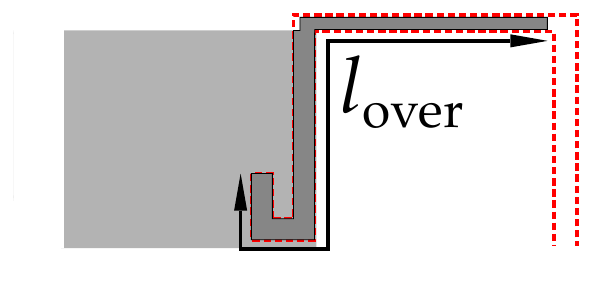
Figure 3. Detailed view of the broadside capacitance involved in the feeding of middle layer resonators.